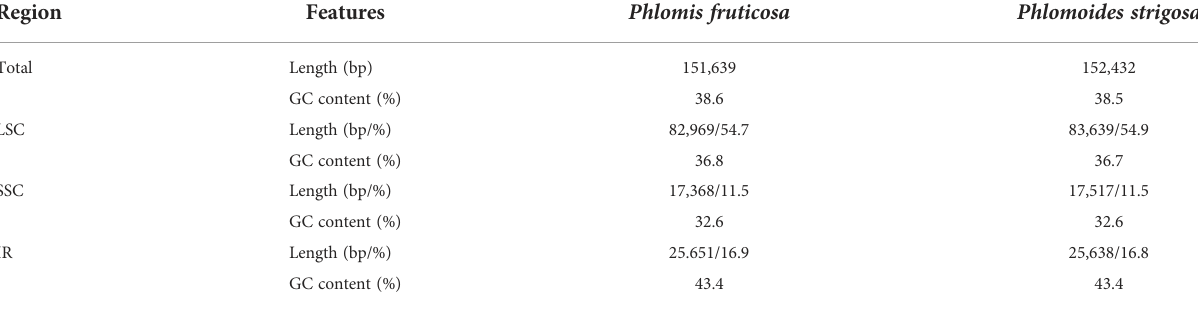
TABLE 1 Summary of chloroplast genomes of Phlomis fruticosa and Phlomoides strigosa .